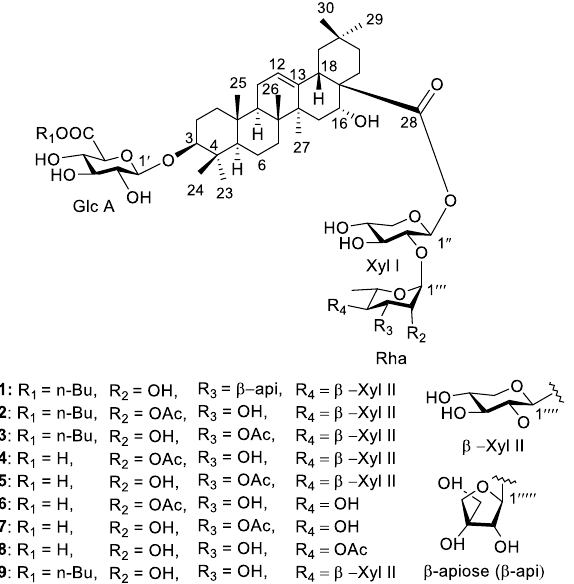
Figure 1. Structures of compounds 1–9 isolated from M. afzelii . Compound 1 was isolated as a white powder from methanol, [𝛼] 𝐷25 +52.6 ( c 0.5, MeOH). Its negative HRFAB−MS showed the deprotonated ion peak [M−H] − at m/z 1245.6211, corresponding to the formula C 61 H 97 O 26 (Calcd for C 61 H 97 O 26 : 1245.6268). The IR spectrum showed characteristic absorption bands for the hydroxyl groups (3377 cm −1 ) and ether groups (1037 cm − 1 ), as well as a strong absorption due to the carbonyl groups (1728 cm − 1 ) [15,19]. The analysis of the 1 H and 13 C NMR data (Table 1) indicated that 1 was a triterpene saponin containing five monosaccharides. The 1 H NMR spectrum of 1 showed seven methyl signals at δ H 1.04 (H-23), 0.84 (H-24), 0.95 (H-25), 0.77 (H-26), 1.36 (H-27), 0.86 (H-29), and 0.94 (H-30), and an olefinic proton at δ H 5.31 (br t, J = 3.7 Hz, H-12) characteristic of olean-12-ene-type triterpenoids [20]. The 13 C NMR spectrum showed 61 signals, among which 30 were assigned to a triterpenoid moiety and 27 to the saccharide moiety (see Table 1). The four additional signals were ascribable to an n -butyl (66.1 (CH 2 ), 31.7 (CH 2 ), 20.1 (CH 2 ), and 14.0 (CH 3 )) unit, which was confirmed by the combined interpretation of the 1 H − 1 H COSY, HSQC, and DEPT 135 spectra [18]. The NMR data of the aglycone moiety of 1 were in good agreement with those of echinocystic acid [18,21], except for the downfield shift of C-3 ( δ C 91.1) and for the upfield shift of C-28 ( δ C 177.2), suggesting that 1 was a bidesmosidic saponin [22,23]. The 1 H NMR spectrum of 1 displayed the signals of five anomeric protons at δ H 5.46 (d, J = 5.6 Hz, H-1 (cid:48)(cid:48)(cid:48) ), 5.16 (d, J = 1.8 Hz, H-1 (cid:48)(cid:48)(cid:48)(cid:48) ), 4.62 (d, J = 7.8 Hz, H-1 (cid:48)(cid:48)(cid:48)(cid:48)(cid:48) ), 5.26 (d, J = 3.8 Hz, H-1 (cid:48)(cid:48)(cid:48)(cid:48)(cid:48)(cid:48) ), and 4.38 (d, J = 7.8 Hz, H-1 (cid:48) 1 ⁗ ), 105.1 (C-1 ′′′′′ ), 111.9 (C-1 ′′′′′ ), and 107.0 (C-1 ′ ), respectively (Table 1). The 1 H NMR